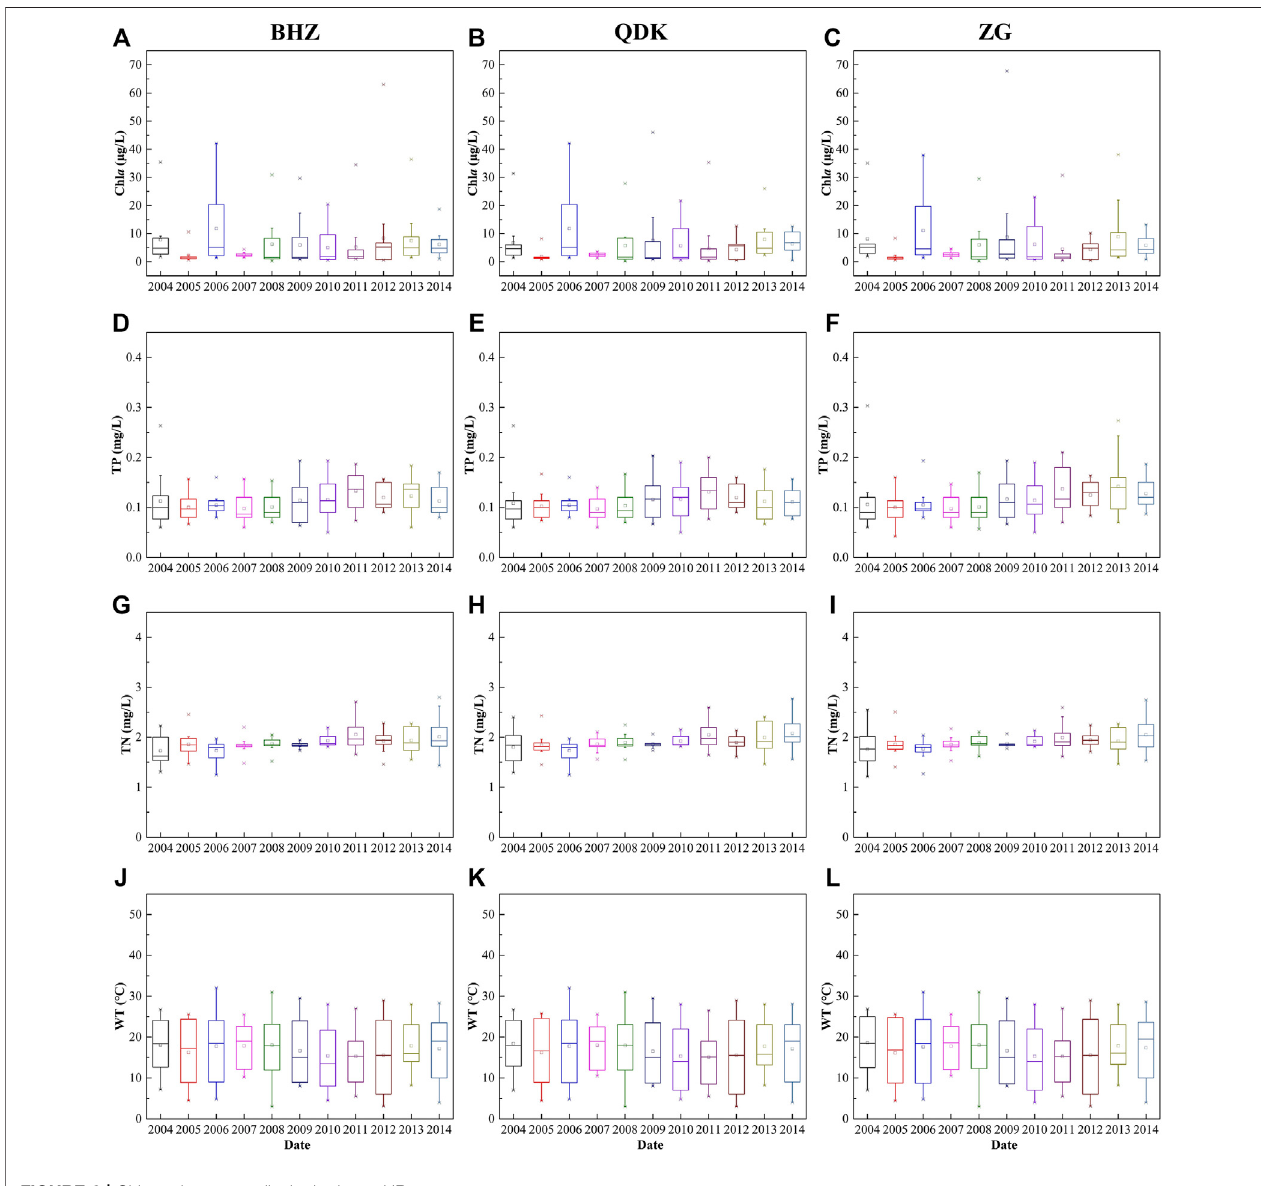
FIGURE 2 | Chl a and water quality in the lower HR.